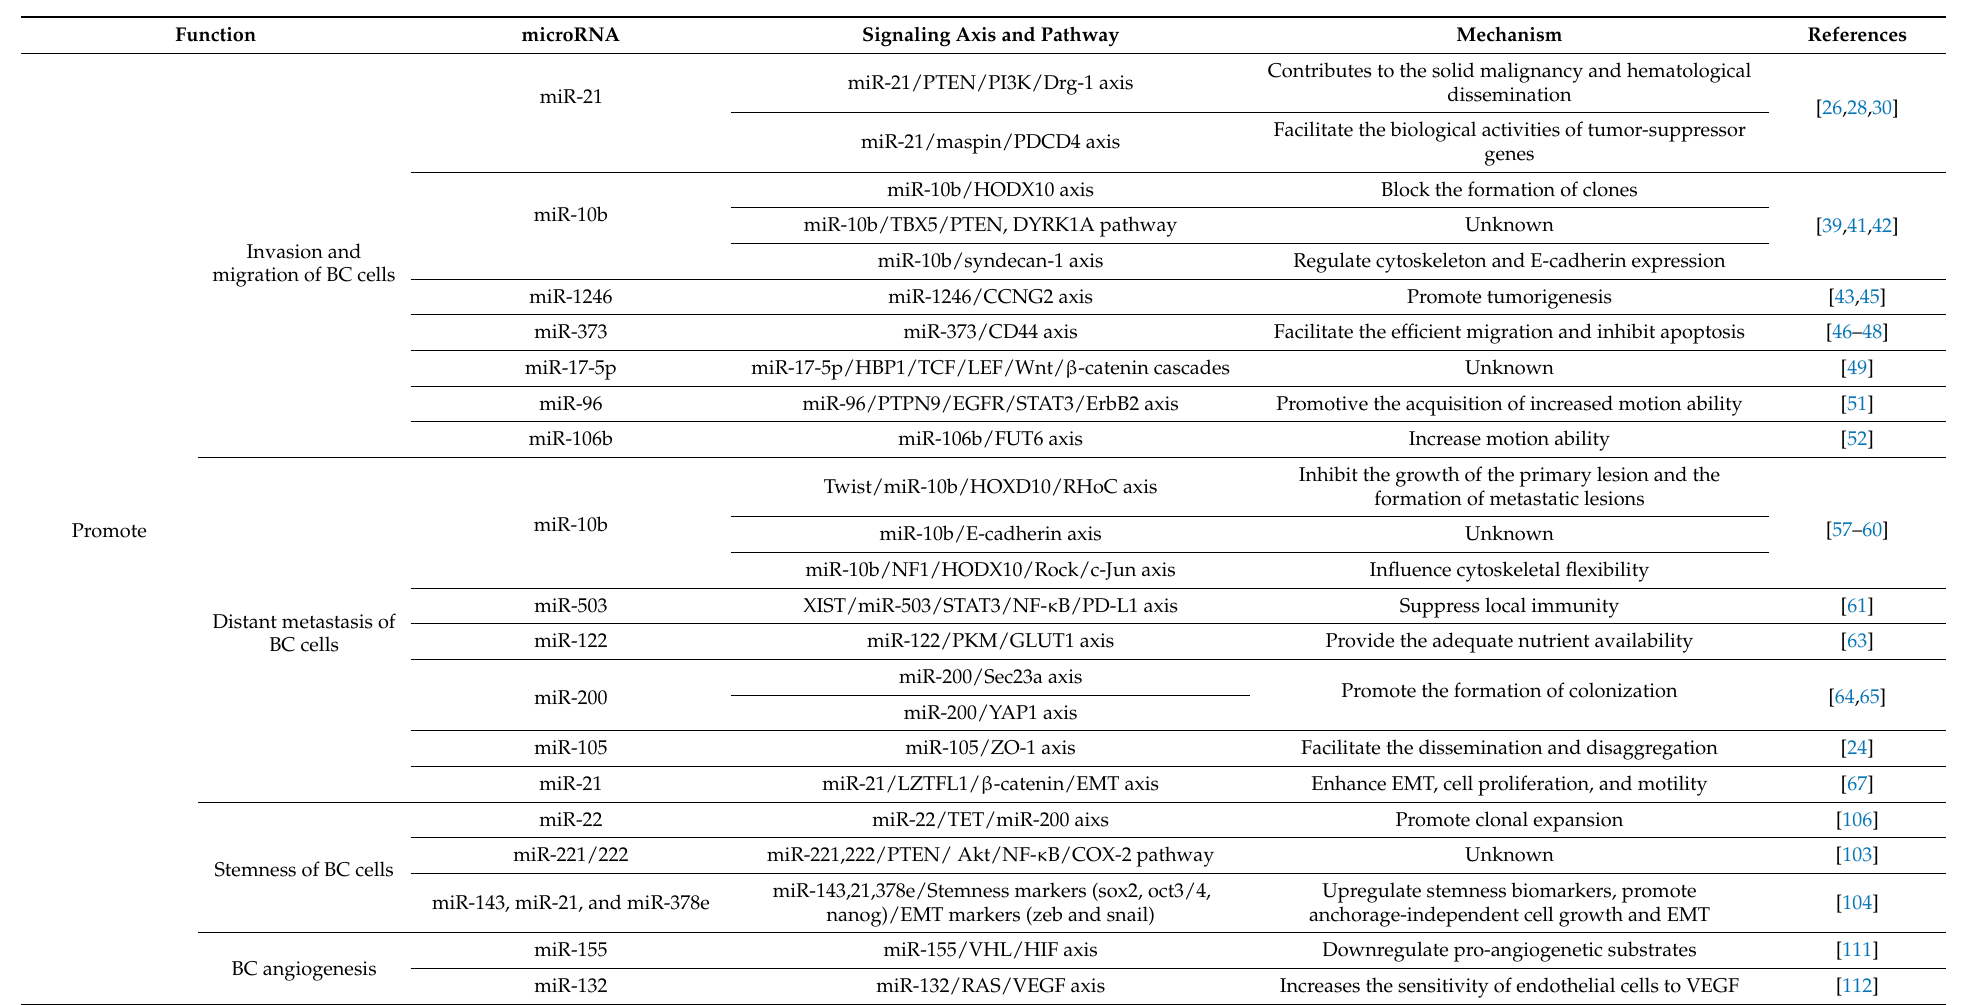
Table 2. Different roles of exosomal microRNAs playing in BC